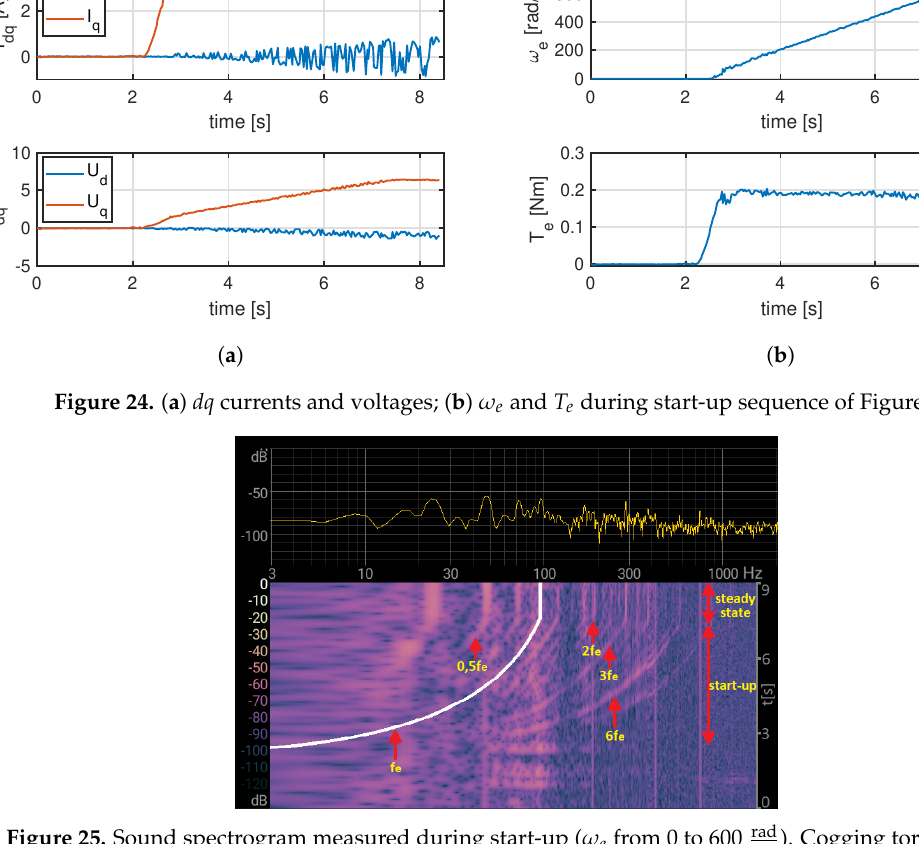
). Cogging torque map s and approx. 50% of rated load. s